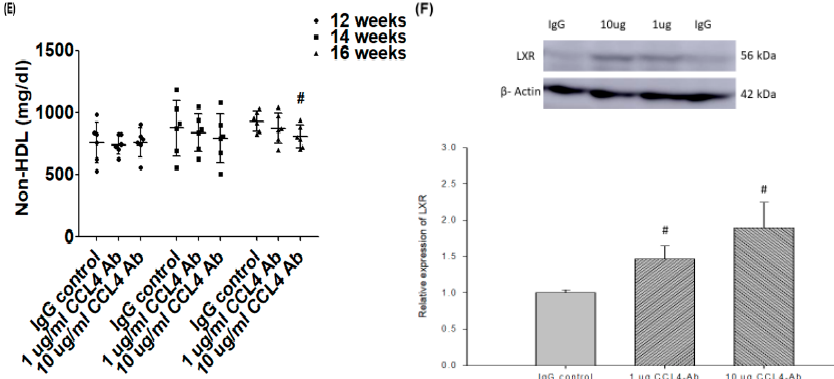
Figure 2. The effects of CCL4 antibodies on metabolic parameters. Blood glucose levels ( A ), body weights ( B ), total cholesterol levels ( C ), triglyceride levels ( D ), and non-high-density lipoprotein (HDL) levels ( E , n = 6 in each group). Western blots and statistical analyses of liver X receptor (LXR) expression in the liver ( n = 3; F ). # p < 0.05 compared with the IgG 2A isotype control